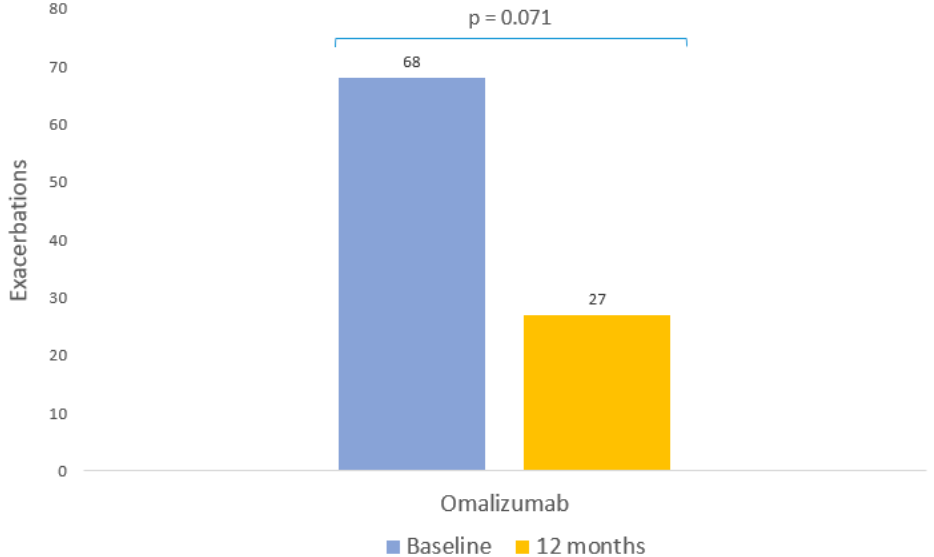
Figure 3. Clinical response to omalizumab: exacerbations. Patients with exacerbations in the 12 months prior to starting omalizumab and after 12 months of therapy.